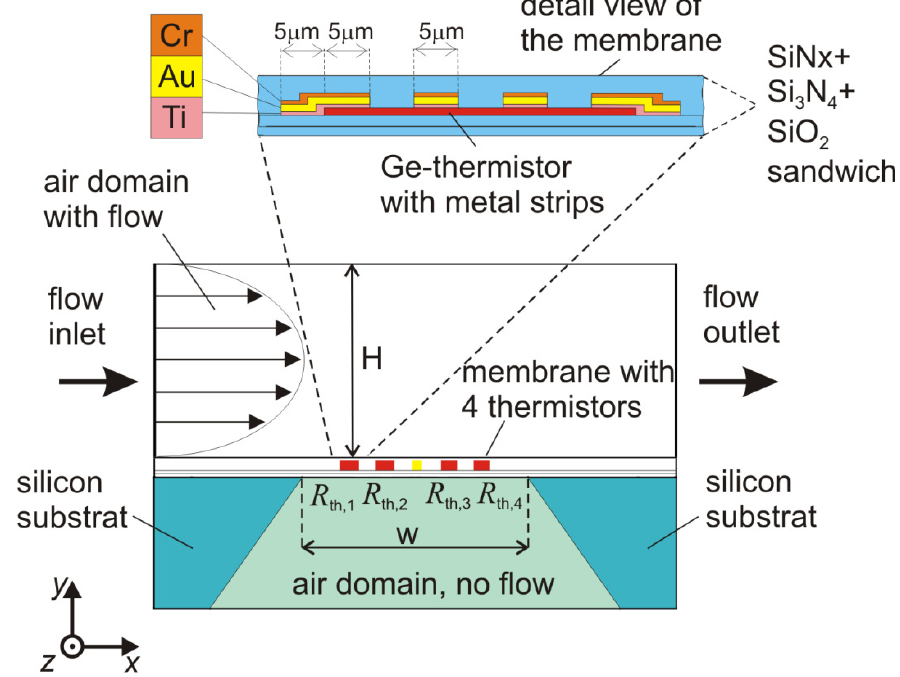
Figure 1. Schematic cross section of the flow sensor. Membrane thermistors ( R are used as thermal actuators and temperature transducers simultaneously. The inset details the thin-film construction of a single thermistor comprising interdigitated electric